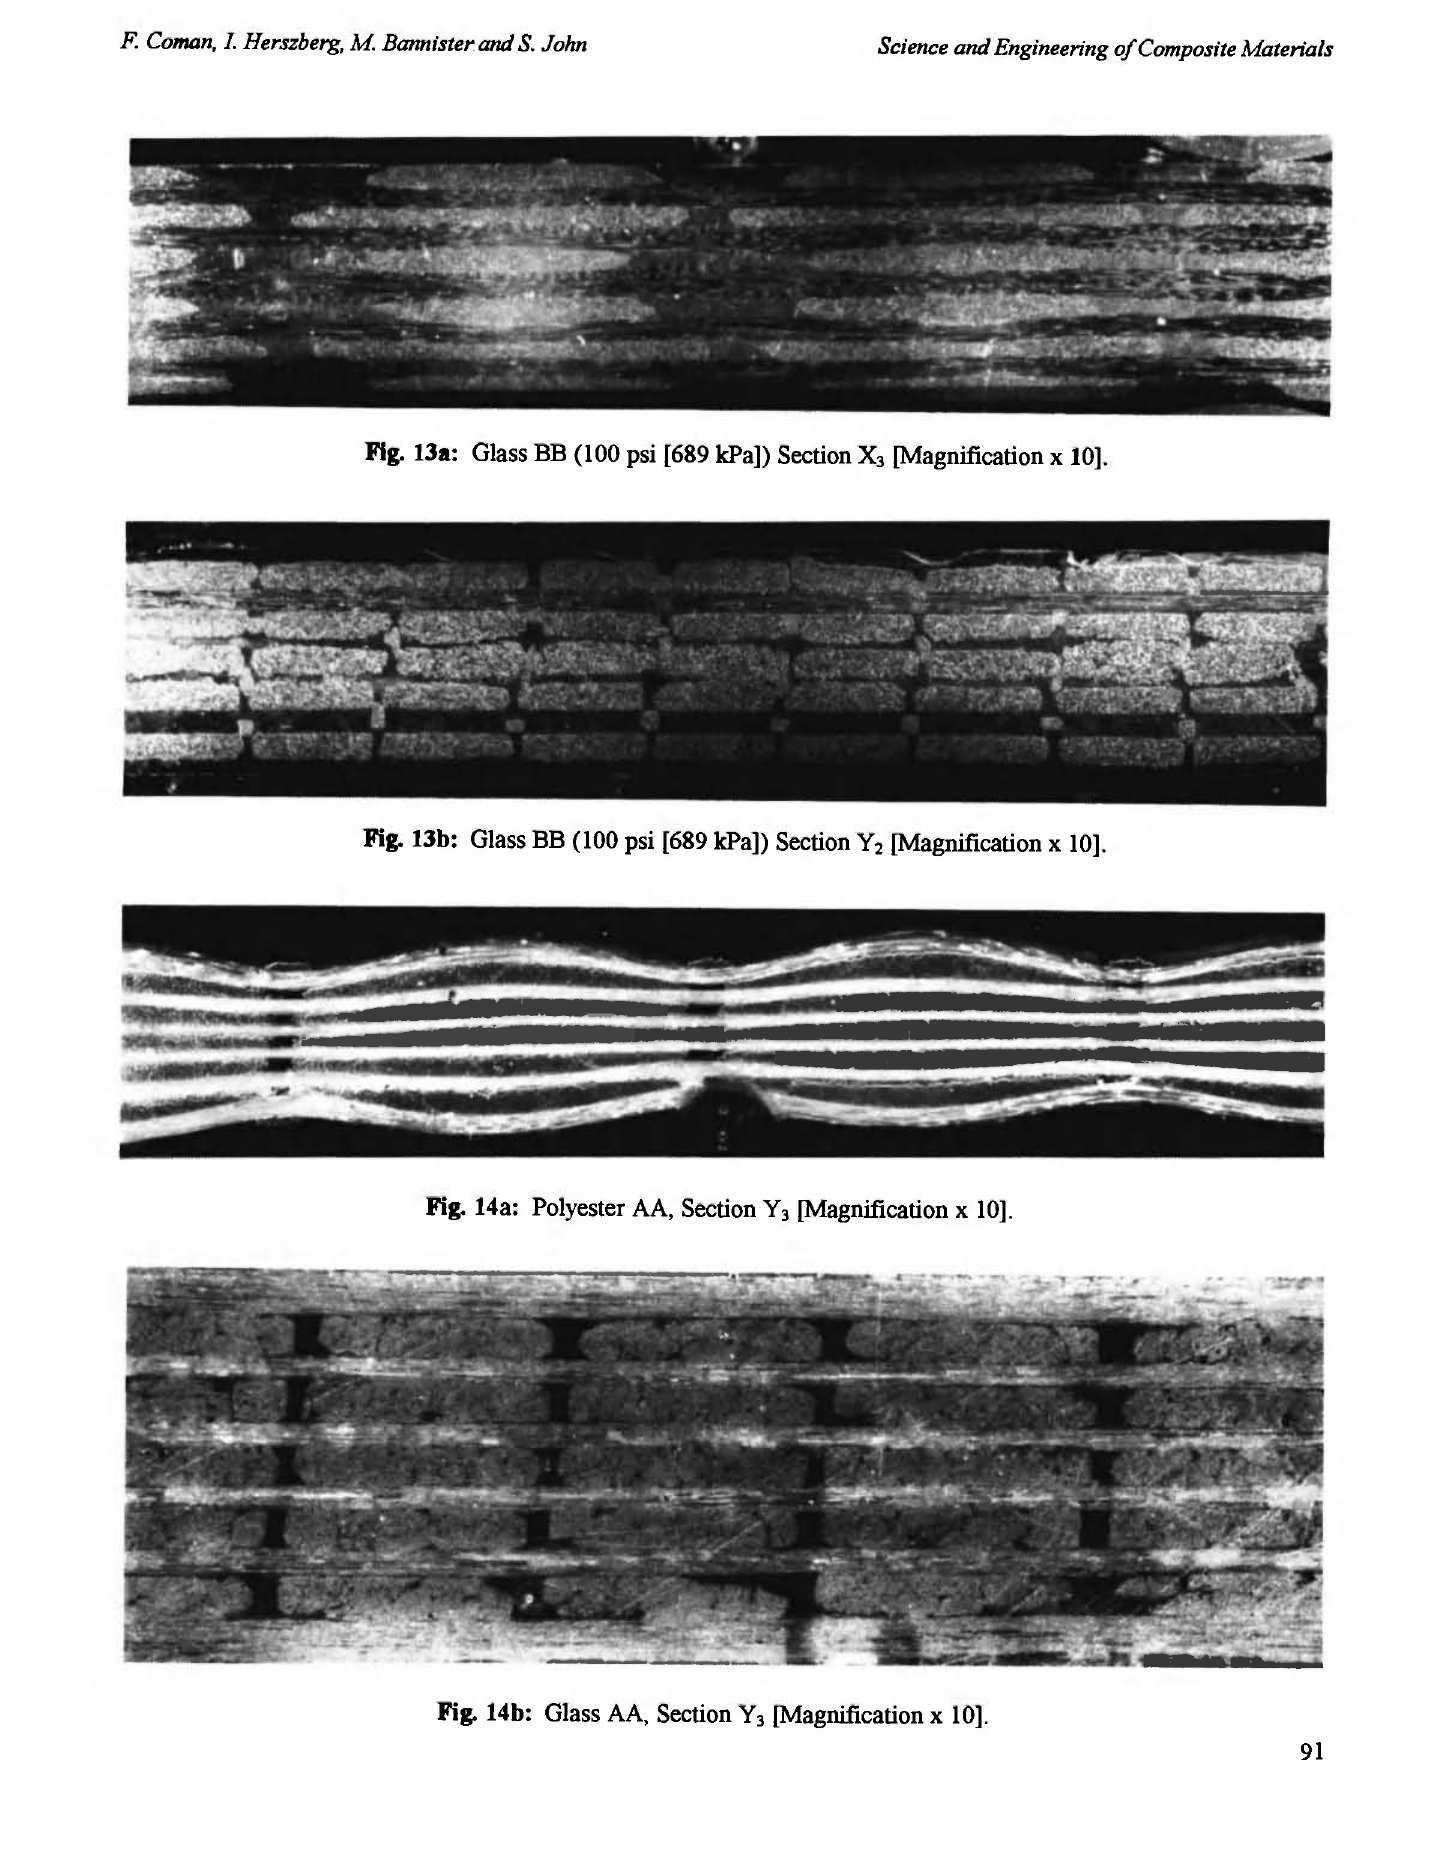
Fig. 14b: Glass AA, Section Y